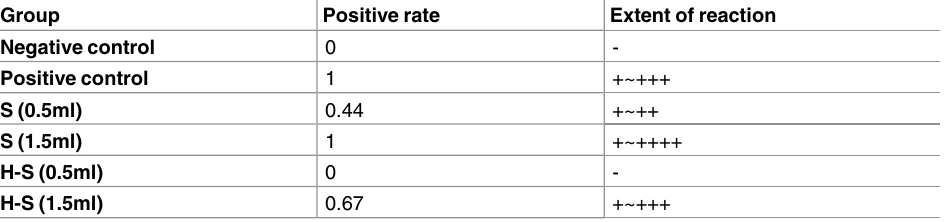
Table 2. GLP allergic reaction test in guinea pig.